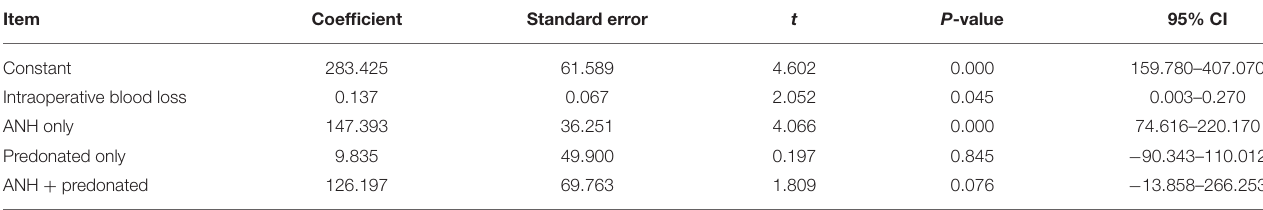
TABLE 4 | Ordinary least squares regression analysis between autologous and allogeneic